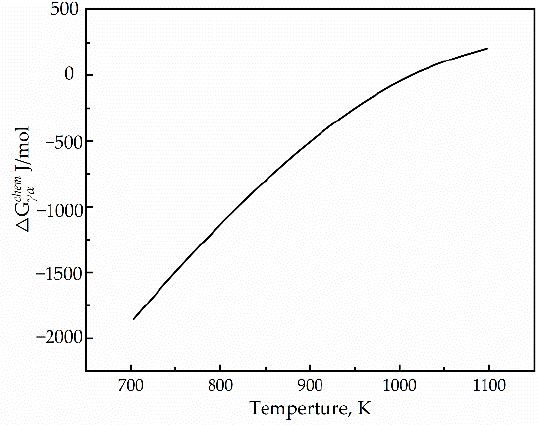
Figure 9. The chemical energy difference calculated by JMatPro.